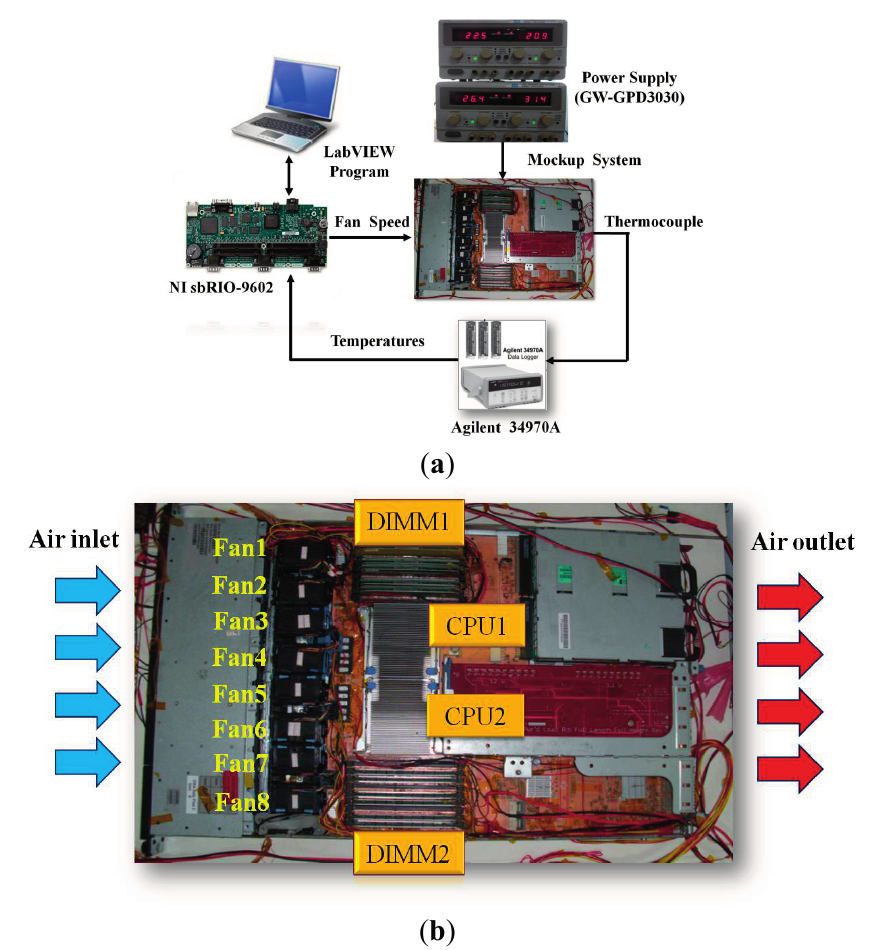
Figure 5. ( a ) Configuration of the server fan control system. Add a descriptive label of the figure here; ( b ) Server mockup